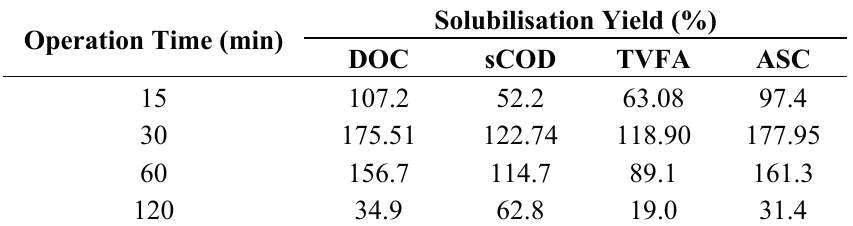
Table 1. Solubilisation yield (SY), expressed in terms of DOC, sCOD, TVFA and ASC, at 160 °C, 6.5 bar and 3 g NaOH/L, for the different operation